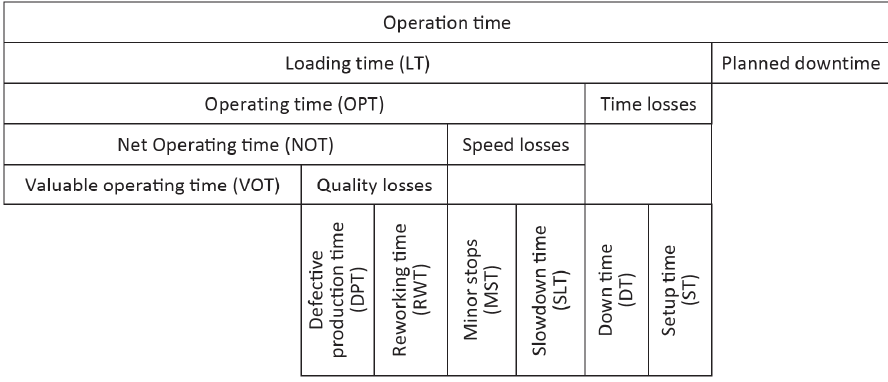
Figure 1. Representation of the OEE time model from Schiraldi and Varisco (2020) [37]. Table 2. Calculation of the TPM OEE. TPM OEE Calculation Methodology